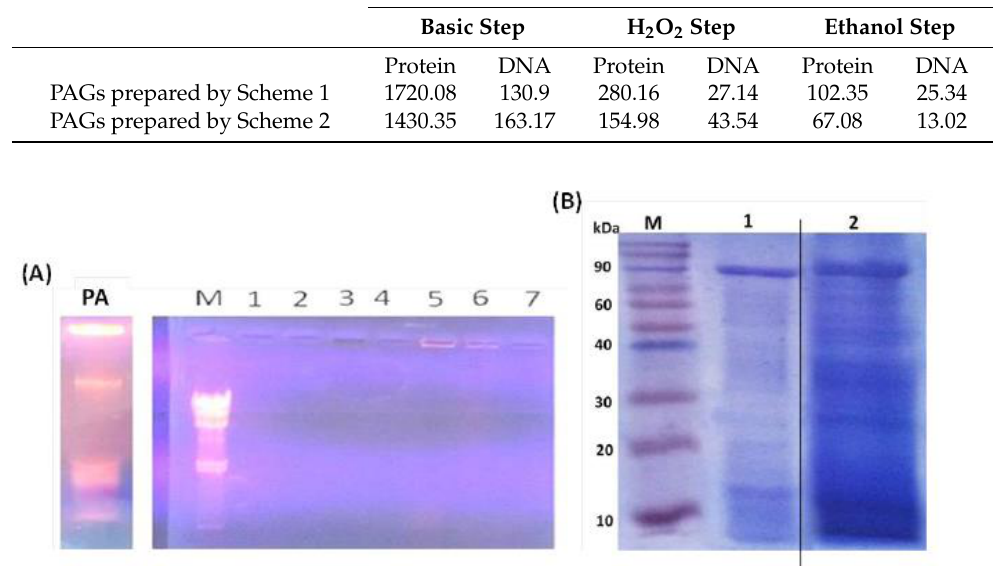
Figure 2 . Characterization of Pseudomonas aeruginosa ghosts (PAGs). ( A ) Agarose gel electropho- Figure 2. Characterization of Pseudomonas aeruginosa ghosts (PAGs). ( A ) Agarose gel resis of prepared PAGs. Lane PA: P. aeruginosa cells showing intense DNA bands; Lane M: DNA